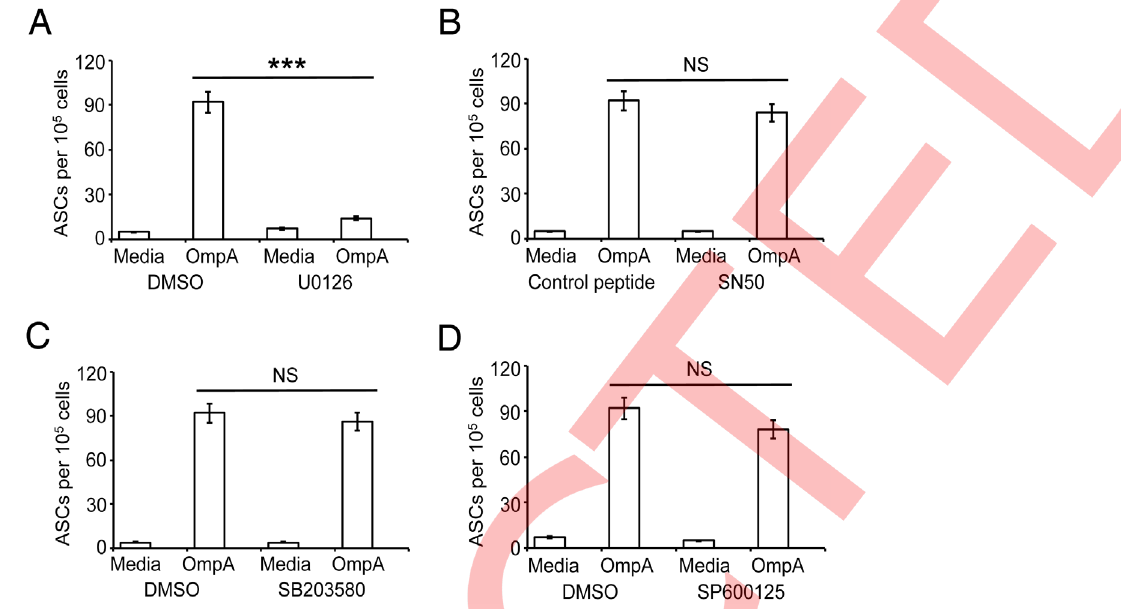
Figure 7. Activation of ERK is critical for OmpA-induced differentiation of B cells into ASCs. B cells were purified from spleen, cultured for 1 h with vehicle or the inhibitors of MEK1/2 (U0126; 5 m M) A , NF- k B (SN50; 100 m g/ml), B , p38 (SB203580; 5 m M), C , JNK (SP600125; 5 m M), D , followed by incubation with OmpA (5 m g/ml) for 72 h. The total number of ASCs (IgM + IgG-secreting cells) was analyzed by ELISPOT. Number of ASCs/10 5 B cells. The results are the mean 6 S.E.M of three independent experiments. ***, p , 0.001, relative to OmpA treated group in the absence of the inhibitor.